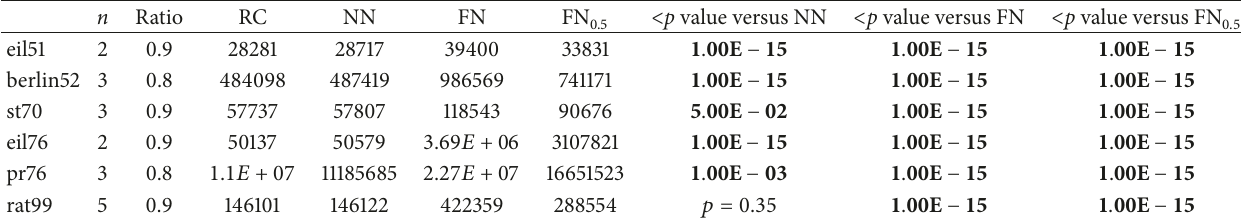
Table 1: Results of the RC algorithm versus the NN, the FN, and the FN 0.5 algorithms for symmetric TSP.